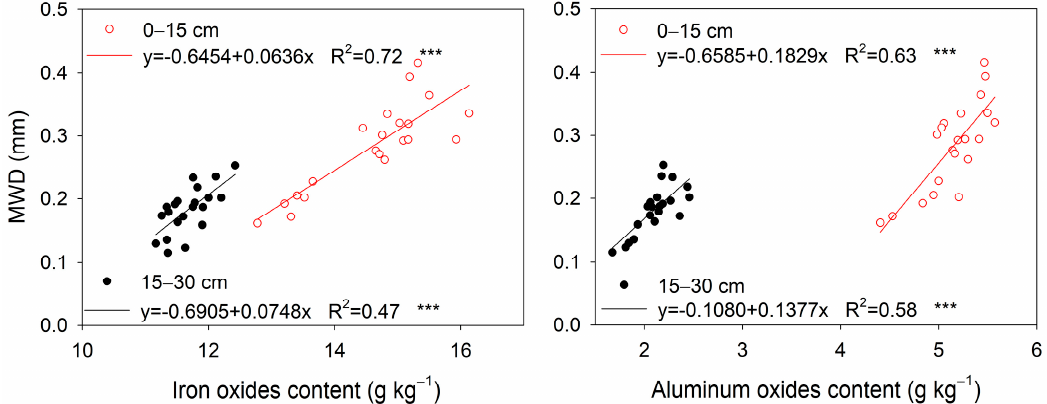
Figure 6. Relationships between mean weight diameter (MWD) and iron oxide and aluminum oxide content. Red and black lines indicate relationships between MWD and iron and aluminum oxides at 0–15 and 15–30 cm depths, respectively. *** p < 0.001.